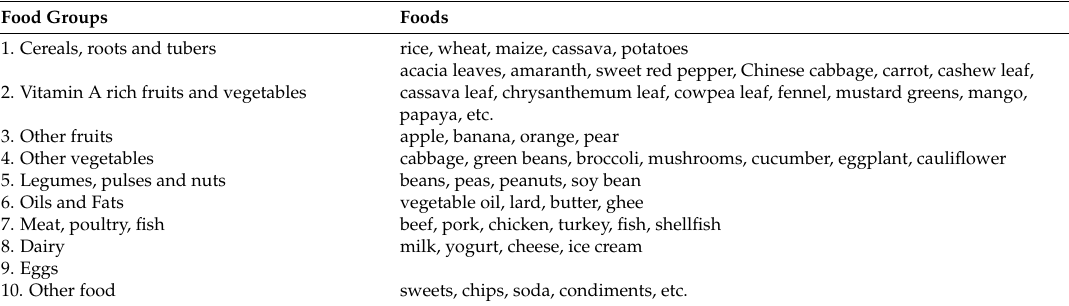
Table 1. Ten food groups of dietary diversity